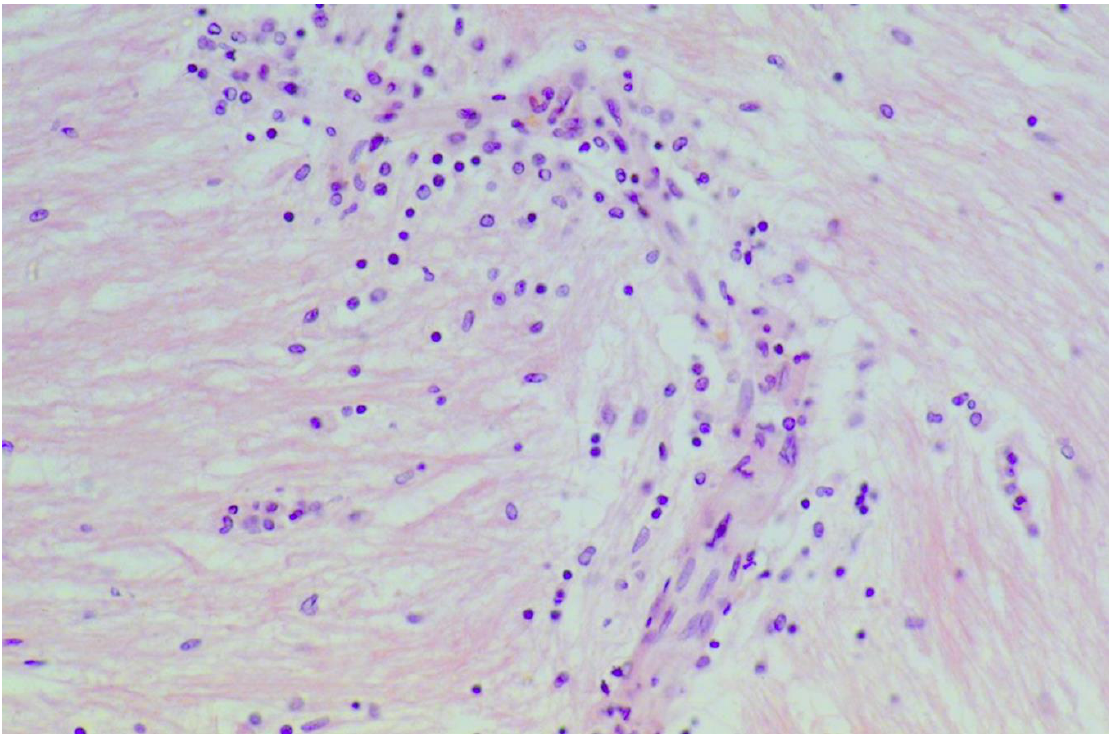
Figure 5. Postmortem cerebral white matter tissue from a patient with gluten encephalopathy showing infiltration with inflammatory lymphocytes and perivascular cuffing (H&E staining, magnification 100×).